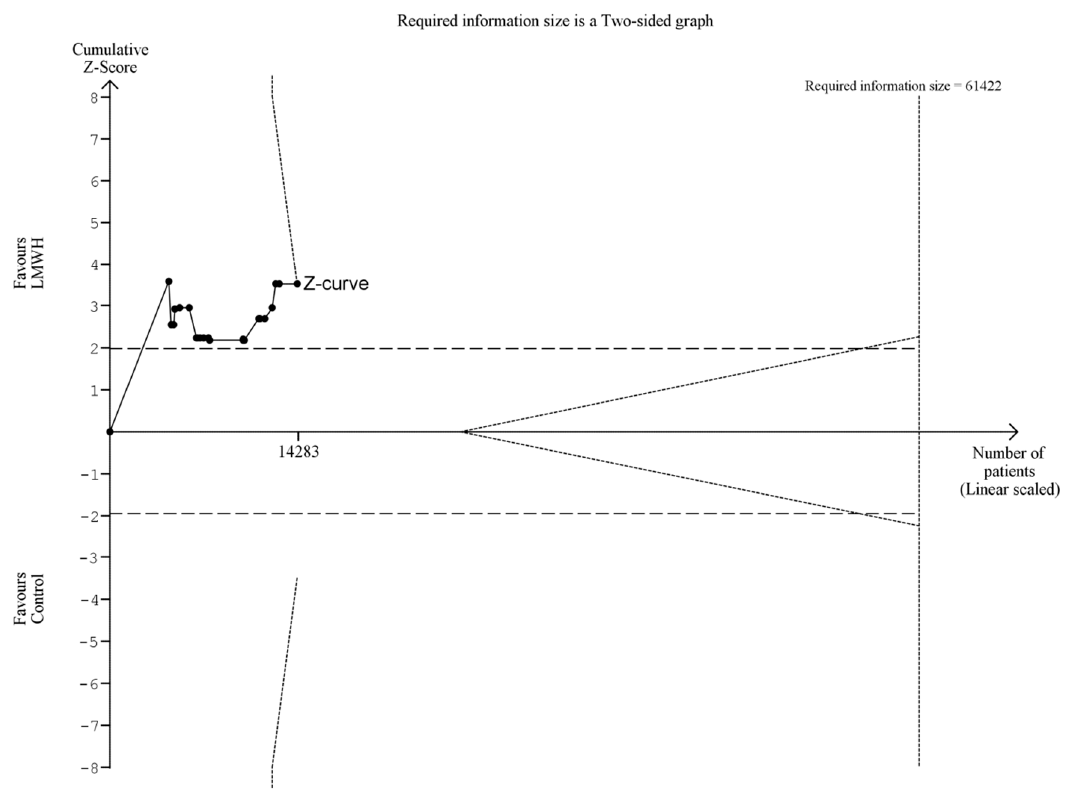
Figure 3. Trial sequential analysis of symptomatic venous thromboembolism (VTE). Trial sequential analysis of symptomatic VTE at maximal follow-up of LMWH compared to placebo or no treatment. The required information size was calculated using α = 0.025, β = 0.90, relative risk reduction (RRR) = 20%, diversity (D2) as suggested by trials, and a control event rate of 1.81%. The cumulative Z-curve was constructed using a random-e ff ects model, and each cumulative Z-value was calculated after inclusion of a new trial (represented by black dots). The dotted horizontal lines represent the conventional naïve boundaries for benefit. The etched lines represent the trial sequential boundaries for benefit (positive), harm (negative), or futility (middle triangular area). The cumulative Z-curve crosses the TSA boundary for benefit, indicating future trials are very unlikely to change the conclusions. Note: the two most recent trials were excluded from this TSA because inclusion would result in an incorrect graphical display of the LanDeMets boundary for benefit. The TSA-adjusted confidence interval remained